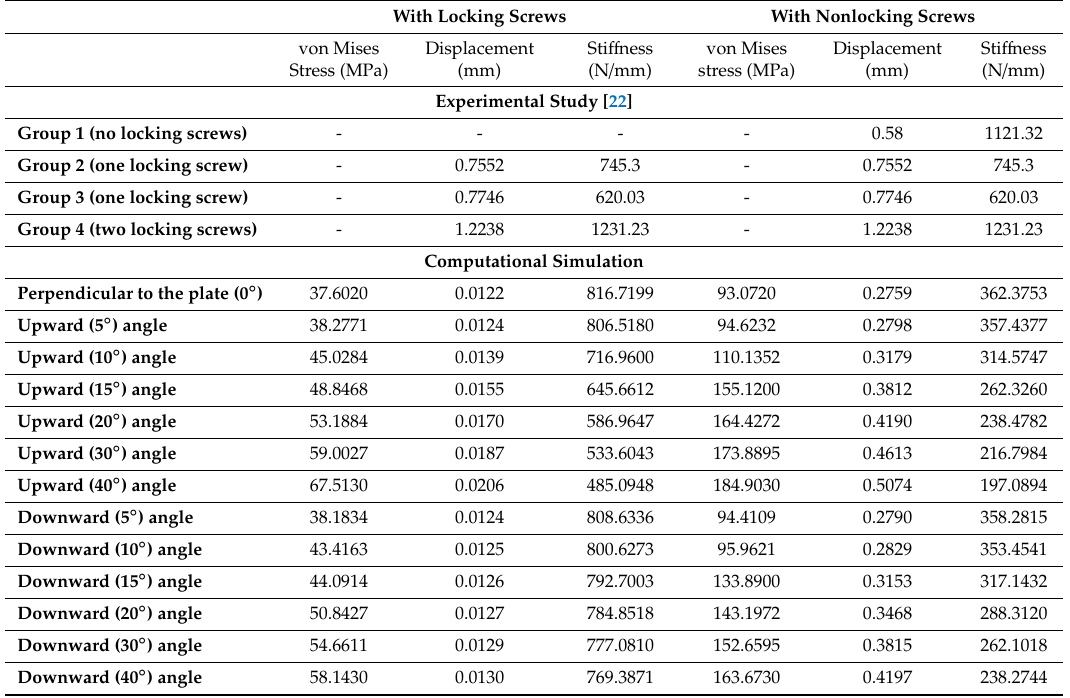
Table A1. The von Mises stress, displacement, and sti ff ness for each model (with locking and nonlocking screws) with di ff erent